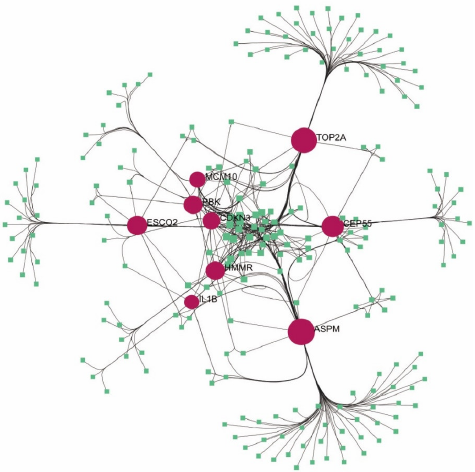
Figure 4. Integrated miRNA–DEG networks for the hub genes. The hub gene was shown in red circle, while the miRNA was in green node. Table 2. Top five candidate miRNAs targeting hub